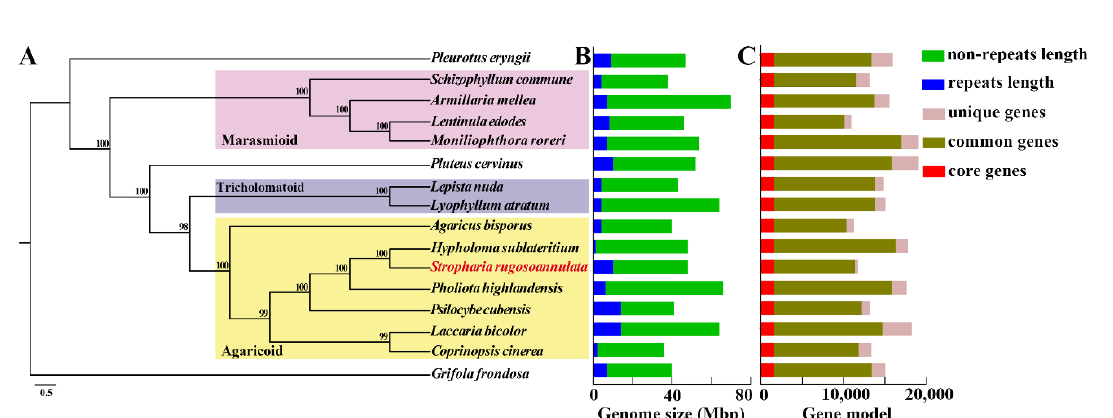
Figure 3. Phylogenetic tree and comparison of the genome features of Stropharia rugosoannulata with the other Agaricomycetes genomes. ( A ) Maximum likelihood tree showing the phylogenetic relationship based on 1609 single-copy orthologs of 16 Agaricomycetes fungi. ( B ) Genome size in Mbp, showing the distribution of the repeat and non-repeat contents. ( C ) Gene model counts of each genome are divided into core genes (present in all genomes), common genes (present in two or more genomes), and unique genes (exclusively found on that genome).